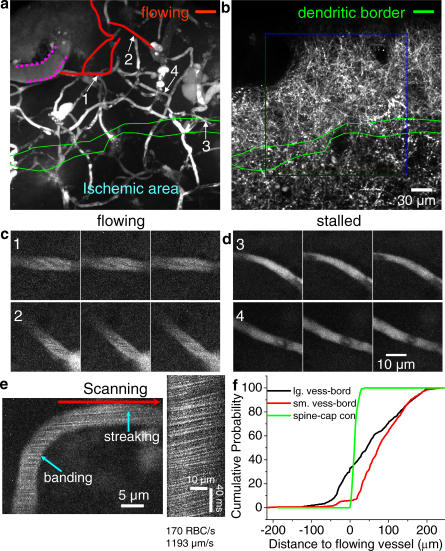
The Relationship between Dendritic Damage Borders and Flowing Vessels(A) Image of the vasculature (maximal intensity projection of first 100 μm of the cortex) 90 min after laser-induced photoactivation of RB. Small flowing vessels are marked in red. The dashed line indicates a large flowing vessel. Green lines denote dendritic damage border as shown in (B).(B) A sub-stack Z-projection (20 μm) showing dendritic structure and dendritic damage border (green lines) 90 min after laser-induced photoactivation of RB. The blue box indicates areas in which dendritic damage borders were examined. Because it was possible that flowing vessels could be located near the edge of an image, a 50-μm buffer zone indicated by the blue line was used to avoid measurements near the border. Distances between the damage border and the nearest small (<15 μm) or large flowing vessel (>15 μm) were made at 10 μm intervals along the green borderline.(C) Representative flowing vessels labeled in (A). Flowing vessels were assessed by determining whether streaking or banding was present (see below).(D) Representative stalled vessels labeled in (A).(E) An example showing vessel streaking or banding that are indicative of objects moving parallel or perpendicular to the direction of scanning (horizontal). The images shown are the average of three consecutive frames, which compresses the width of the bands due to overlap. This single vessel was oriented both parallel and perpendicular to the scan axis and shows that streaks are converted to bands when the angle between the scan direction and the vessel changes (this was also demonstrated by turning the scan angle 90 degrees, not shown). A single linescan through the horizontal part of this flowing vessel is shown on the right showing the velocity and supply rate of RBCs for this vessel.(F) Group data from ten different animals show the cumulative probability distribution of distances between the dendritic damage border and the nearest flowing small or large vessel; to small vessel (n = 673 measurements, red line); to large vessel (n = 704 measurements, black line) after RB photothrombosis. The cumulative probability distribution of distances between individual spines and the nearest flowing capillary in normal animals (green line) are also shown for comparison; from n = 3 animals (250 measurements) from [15]. The cumulative probability distributions were significantly different between groups (Kolmogorov-Smirnov test, p < 0.0001).